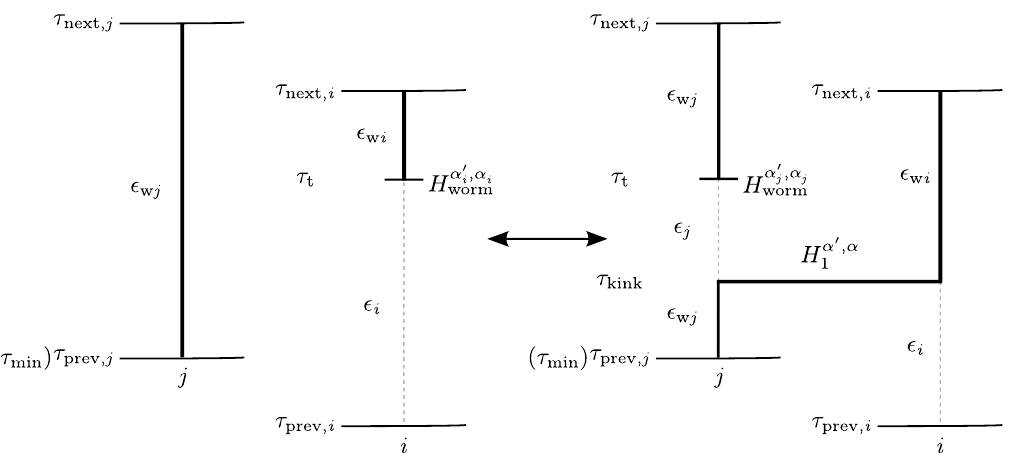
∈ [ τ ) and the , τ kink min t